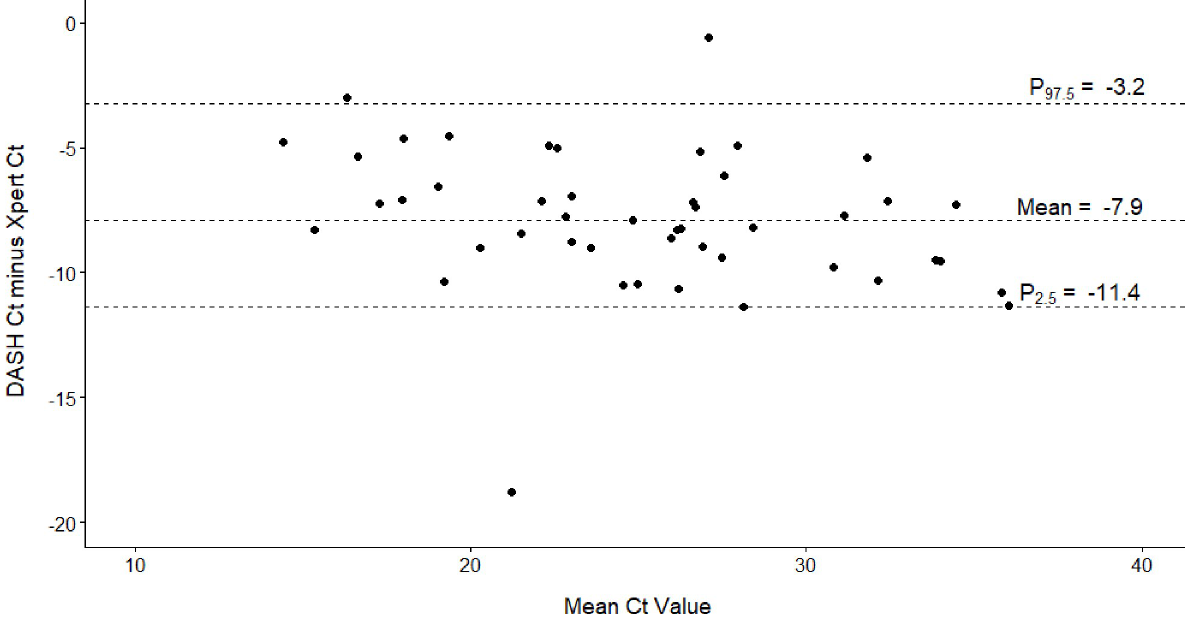
Fig 4. Bland-Altman analyses for comparison of Diagnostic Analyzer for Selective Hybridization (DASH) PCR and Cepheid Xpert Xpress PCR cycle threshold (Ct) values. https://doi.org/10.1371/journal.pone.0270060.g004 PLOS ONE | https://doi.org/10.1371/journal.pone.0270060 June 16,